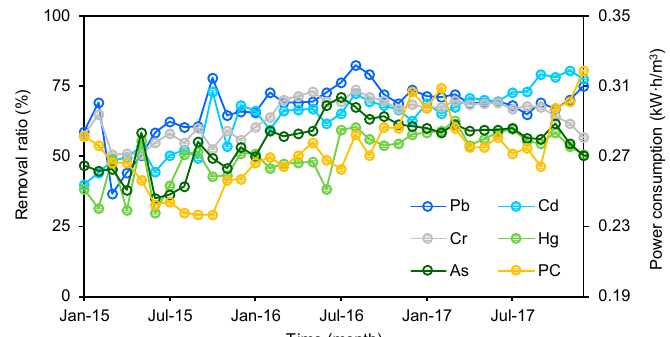
Figure 2. Apparent removal ratios of five heavy metals and power consumption (PC) at sampled MWTPs.